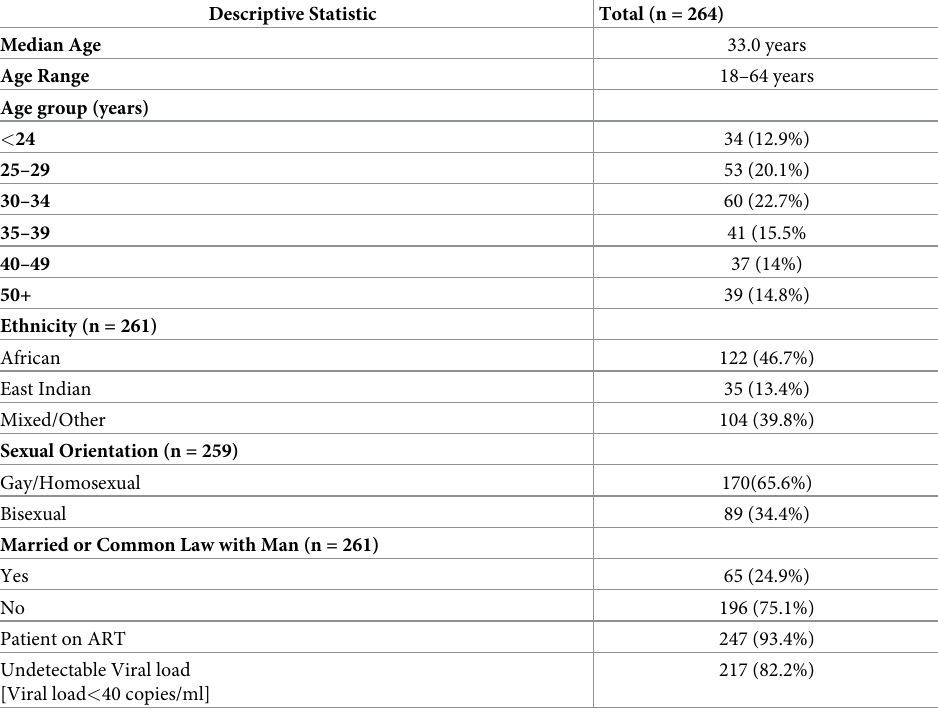
Table 1. Baseline characteristics of the study population (n =